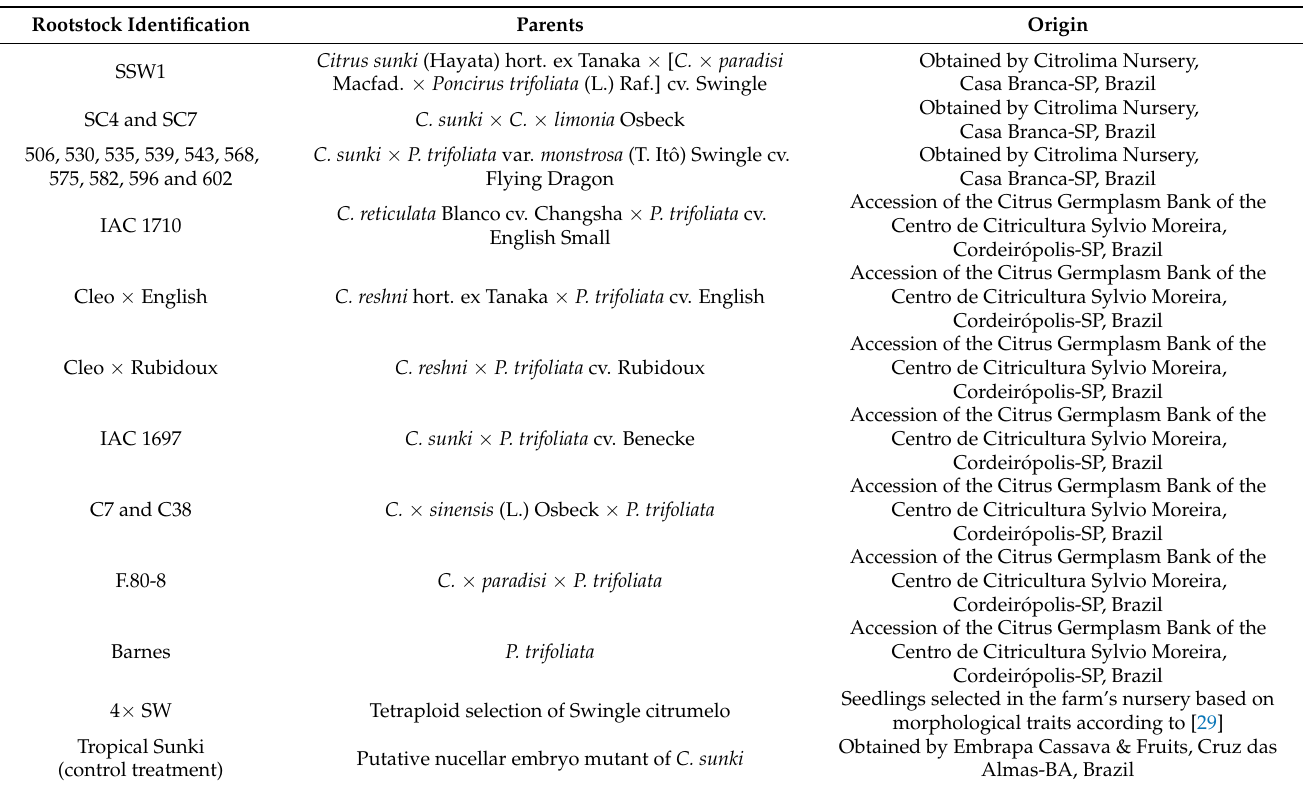
Table 1. RootstocksgraftedwithValenciasweetorange[ Citrus × sinensis (L.)Osbeck]andevaluatedinNorthernS ã oPaulo State, Brazil. Rootstock